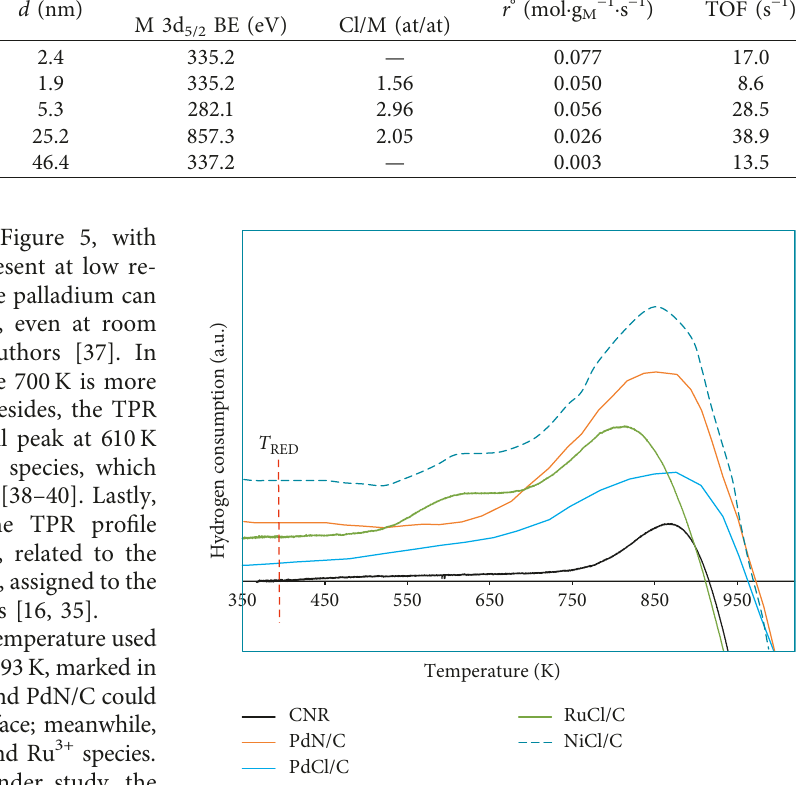
Figure 5: TPR profiles of PdN/C, PdCl/C, RuCl/C, and NiCl/C catalysts and the CNR support.